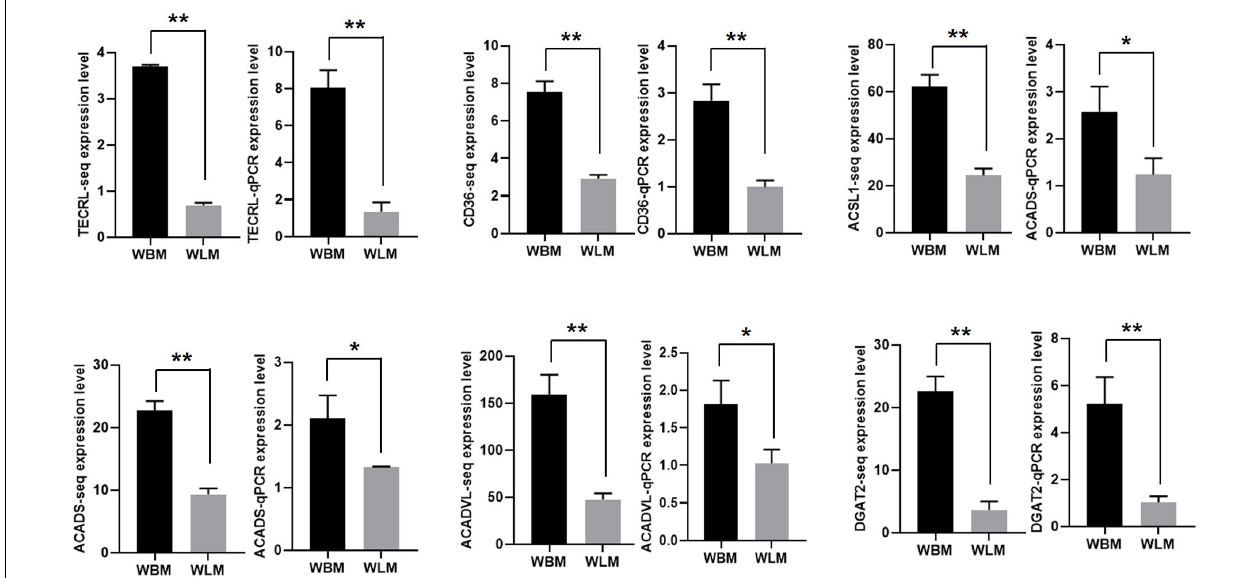
FIGURE 5 | The expression of mRNA related to unsaturated fatty acid synthesis and metabolism. Biceps femoris muscle (WBM): high-fatty acid content group. Longissimus dorsi muscle (WLM): low-fatty acid content group. Expression of genes were normalized by β -actin. The asterisks represent the levels of significance ( t -test: * P < 0.05, ** P < 0.01).